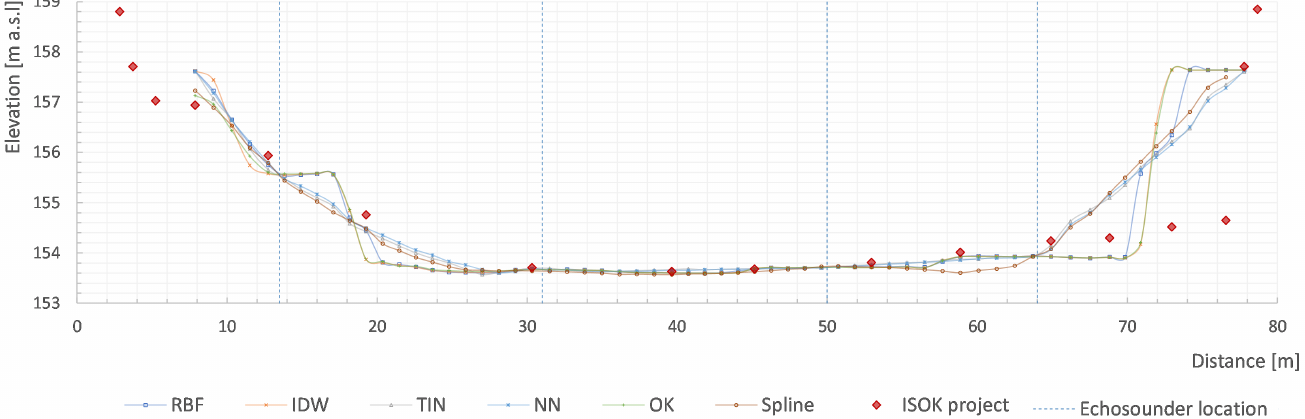
Figure 9. Cross-section of the km 125 + 200. Cross-section C (XS C) displayed in Figure 3.